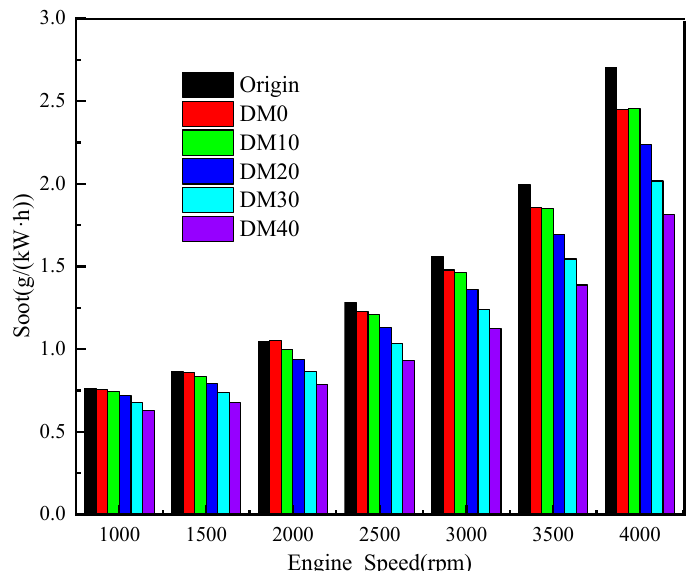
Figure 9. Effect of different ratios of methanol-diesel mixtures on soot emission at different speeds.